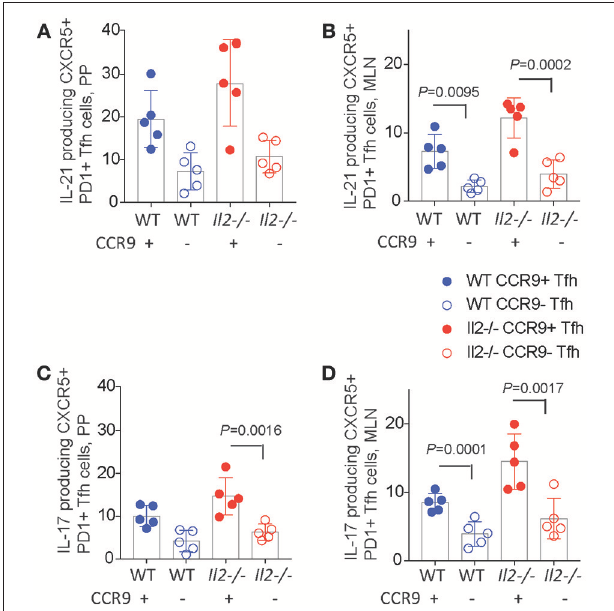
FIGURE 5 | CCR9 + Tfh cells express increased amounts of IL-21 and IL-17. Percentages of cytokine expressing CCR9 + and CCR9 − , CXCR5 + PD1 + CD4 + T follicular helper (Tfh) cells in the Peyers patches (PP) and mesenteric lymph nodes (MLN) of Il2 − / − and WT mice. Interleukin (IL) 17 and 21 were detected ex vivo by intracellualr immunostaining and FACs analyses. IL-21 containing CCR9 + and CCR9 − Th cells in the (A) PP and (B) MLN. IL-17 containing CCR9 + and CCR9 − Th cells in the (C) PP and (D) MLN. Data are shown as mean ± SD from 3 experiments, where n = 5 female mice of 9–12 weeks of age. Statistical significance was assessed by 2-way ANOVA using Bonferroni’s multiple comparisons